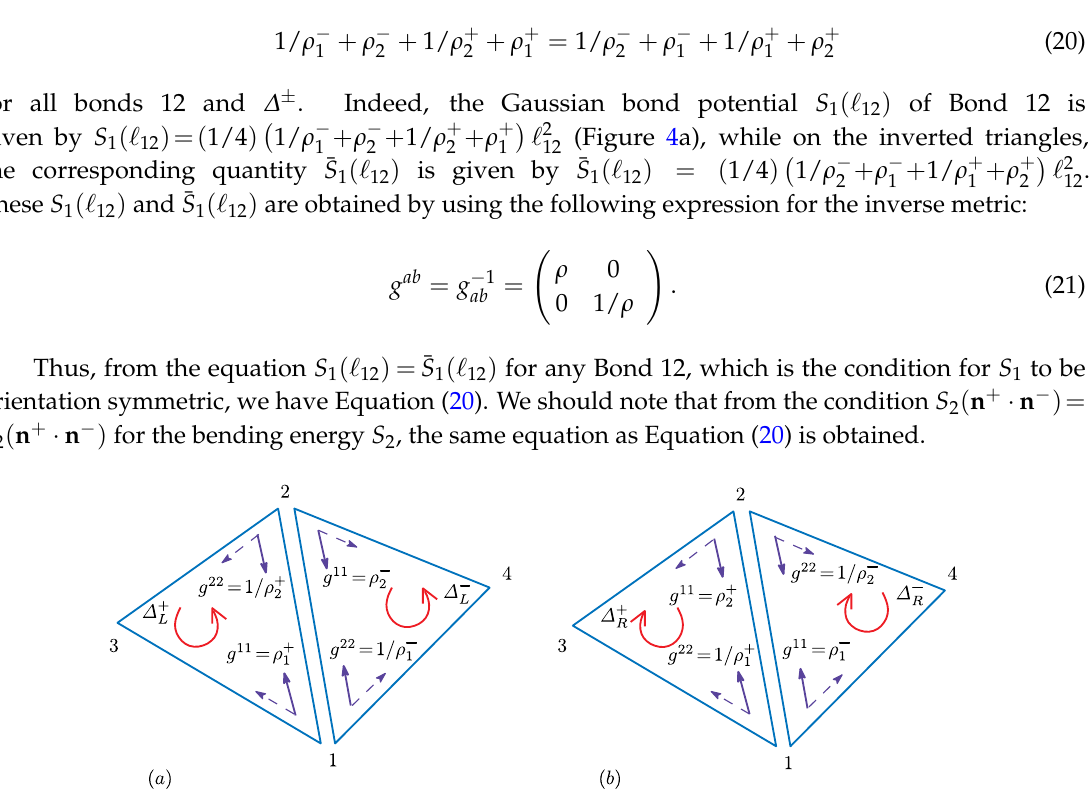
and elements of the inverse metric g ab for S 1 and S 2 ; L (inside R